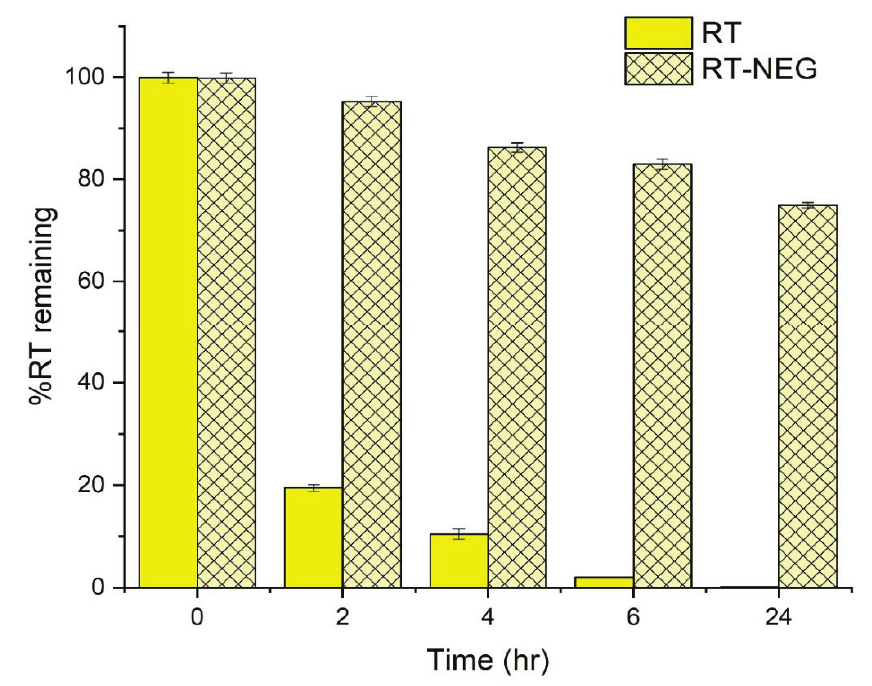
Figure 8. UV stability of pure retinyl palmitate (RT) and the RT nano-emulgel system.